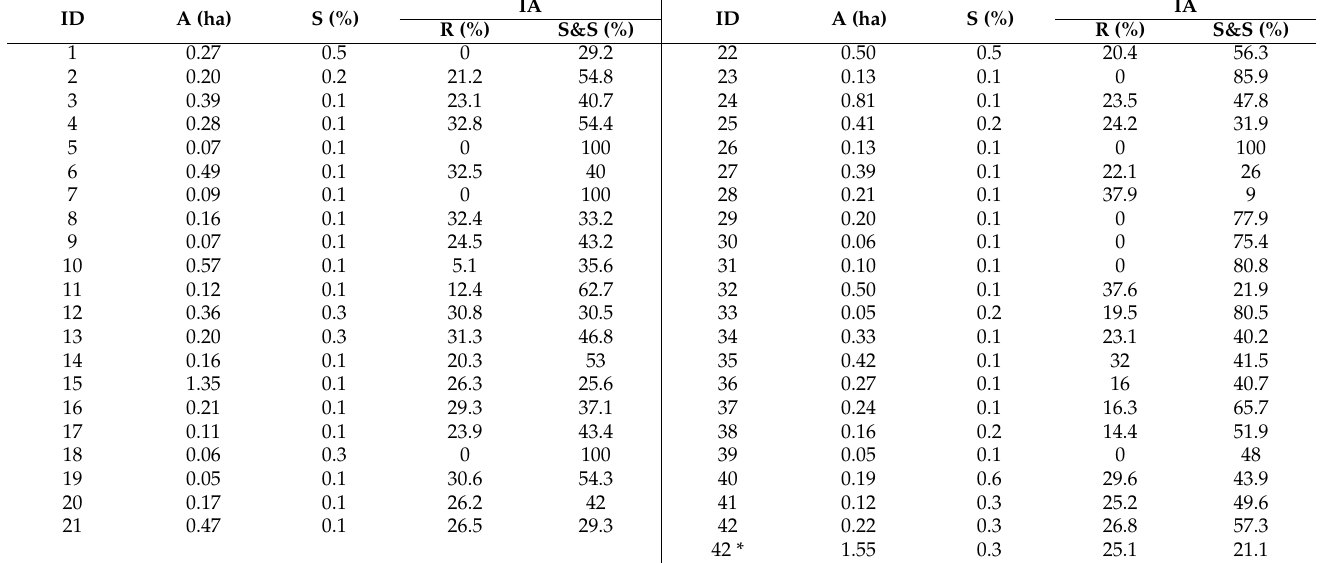
Table 1. Cascina Scala sub-catchment characteristics. See footnote for description of the symbols.